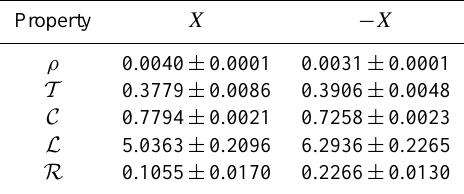
Table B1. VG and HVG properties for the hemispheric sunspot area time series and their negative counter-parts.